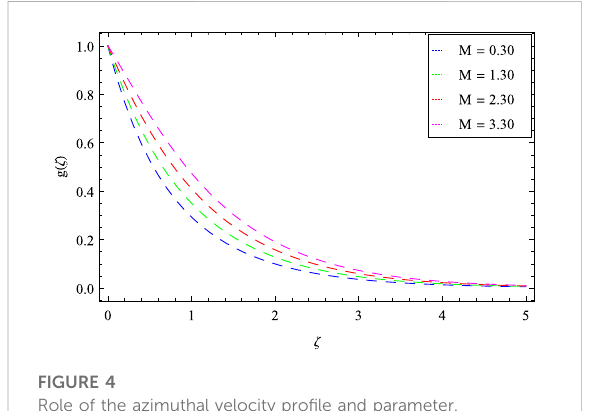
FIGURE 4 Role of the azimuthal velocity pro fi le and parameter.